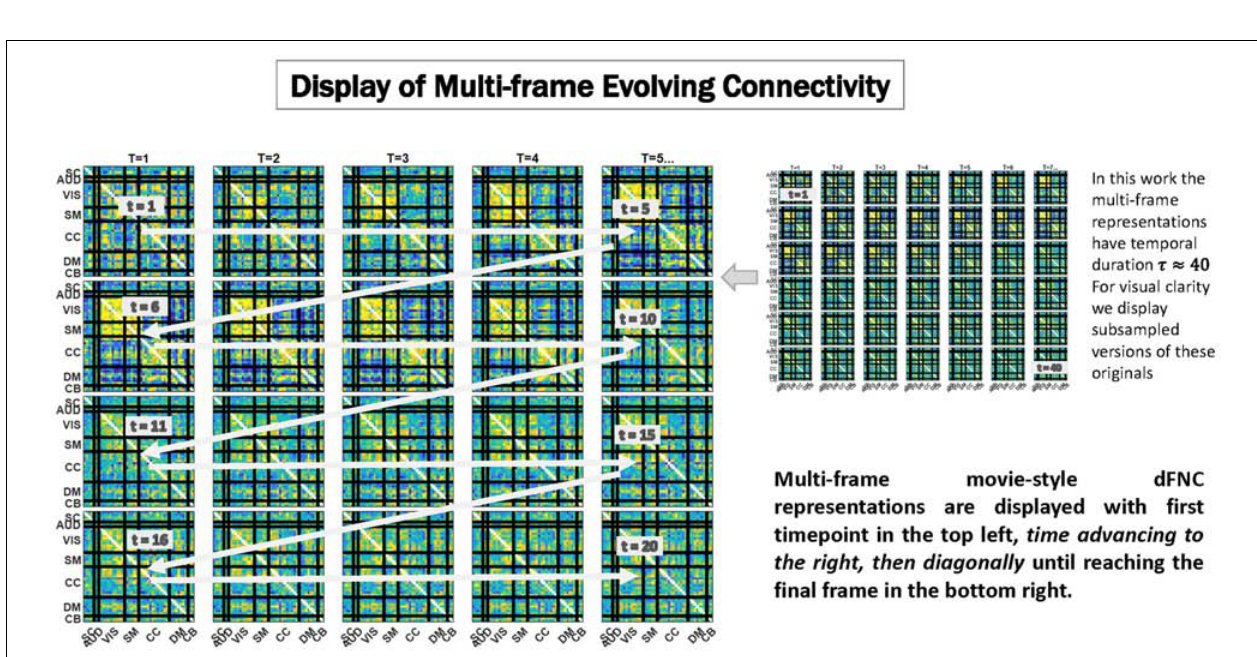
FIGURE 5 | The linear trajectory segments (LTSs) (top right) along the boxed embedded trajectories (top left). These local linearizations are clustered to identify a set of linear trajectory exemplars (bottom right, superimposed black and red segments) capturing localized directional trends in the dynamics.